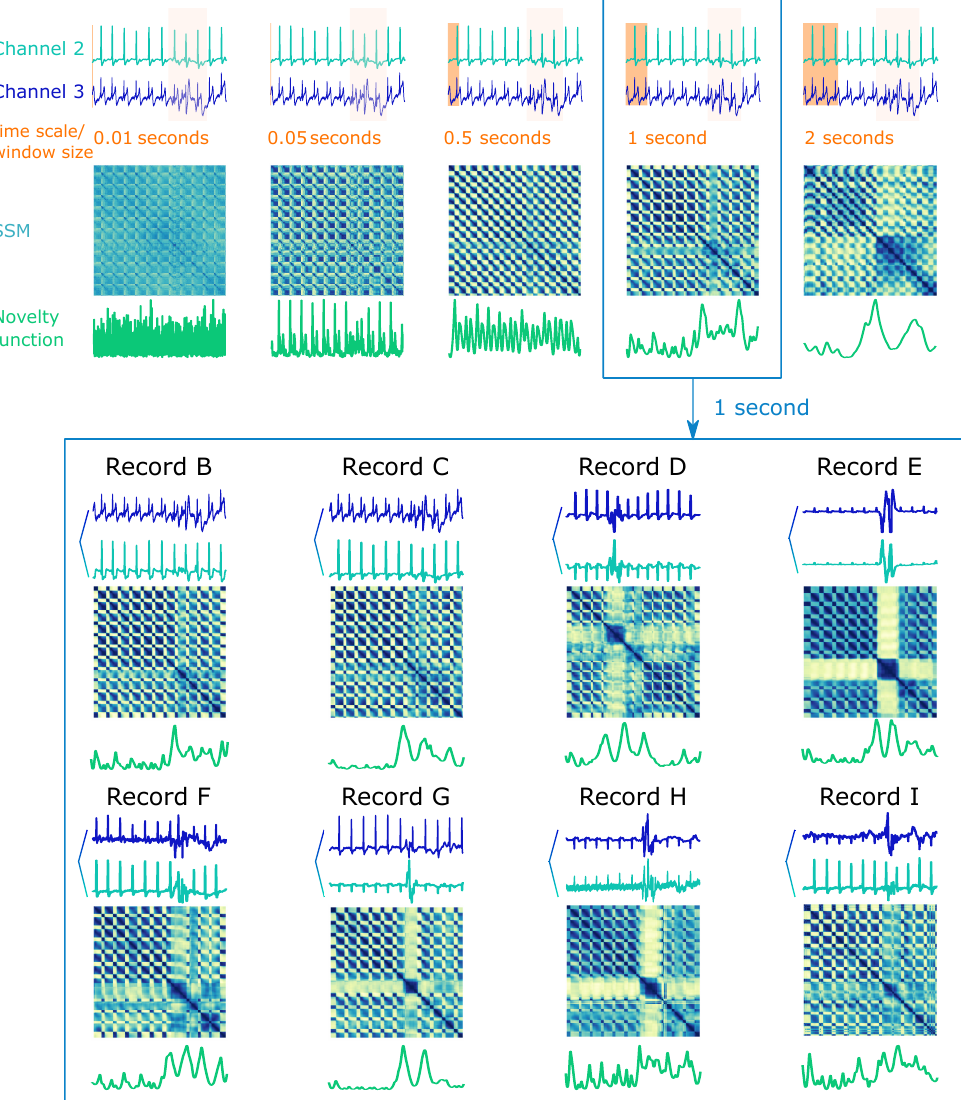
Figure 11. An illustrative example of window length intuition on records of Dataset 2 (ECG1, see Section 3.2). Top: different SSMs on the same ECG record A computed with sequentially larger window lengths from 0.01 to 2 s. The novelty functions are calculated with a kernel size equal to the window size and an overlap of 95%. Bottom: The 1-second window length is further applied as an example to indicate that parameters turned in the representation experiments can be generalized to all other records of the same dataset (B-I) to compute their corresponding SSM representations and novelty